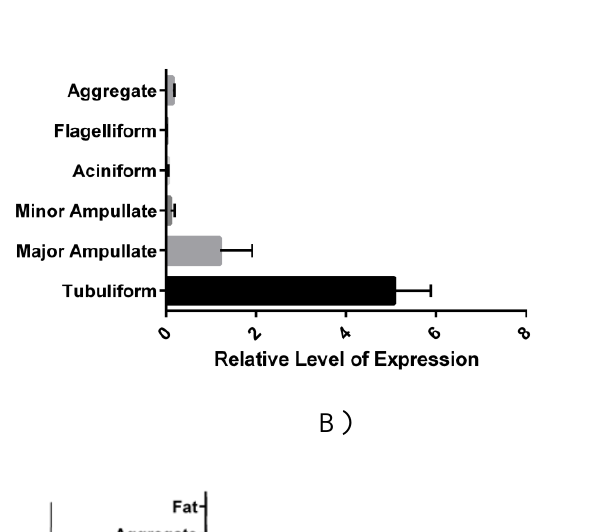
(Figure 5). Analysis of our MS/MS data from in-solution tryptic digestion of the tubuliform